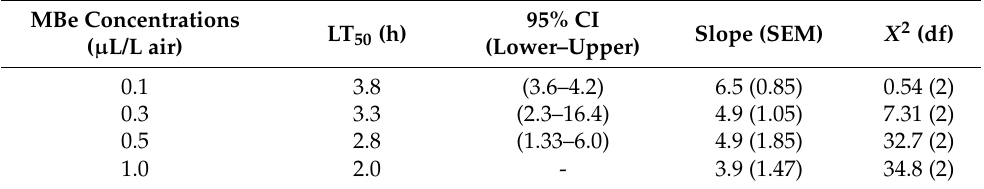
Table 1. Probit analysis of time-mortality responses of Plodia interpunctella adults exposed to various concentrations of methyl benzoate (MBe).